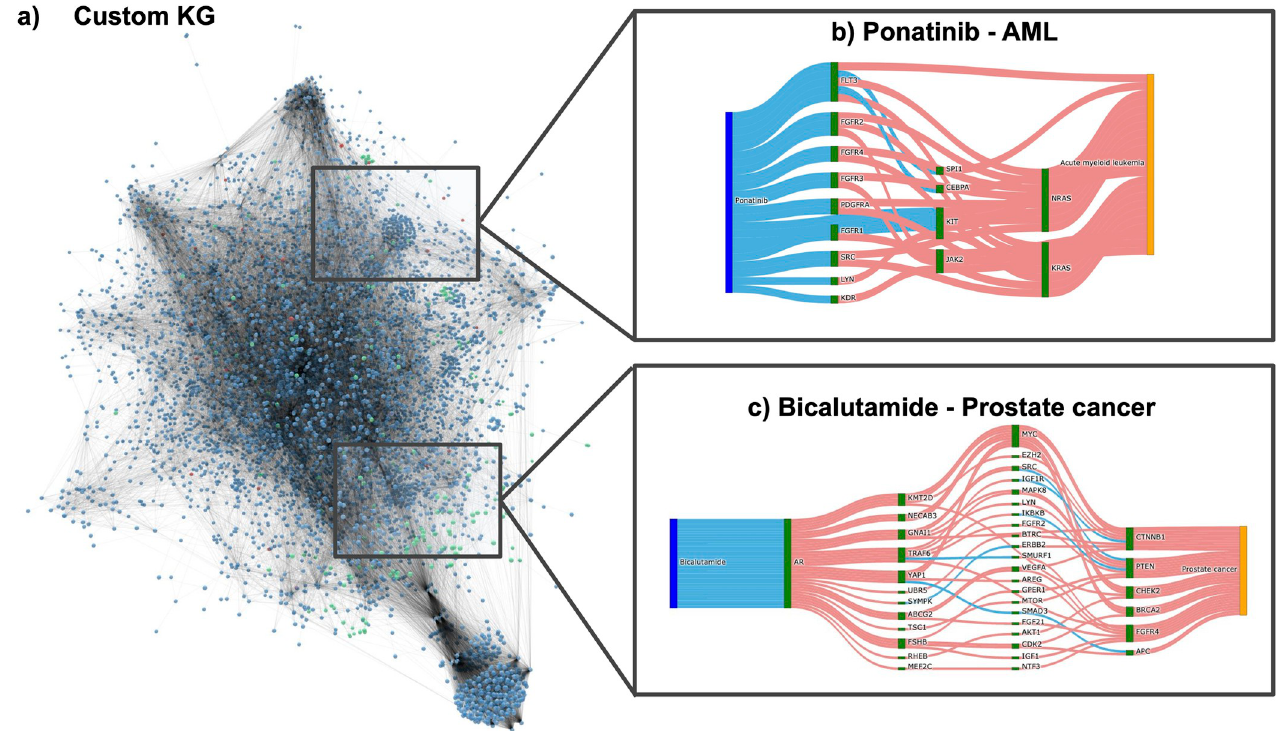
Fig 2. Devoncoluting the mechanism of action of a drug through RPath. By investigating all the paths of a given length between a drug and a disease in a KG, we can analyze the different mechanisms that are proposed by RPath. a) Visualization of the custom KG. Proteins are colored in blue, diseases in red and drugs in green. Sankey diagram illustrating a sample of the paths between ponatinib and AML (b) and bicalutamide and prostate cancer (c) for the custom KG. Activatory relations in the Sankey diagrams are colored in red and inhibitory relations in blue.